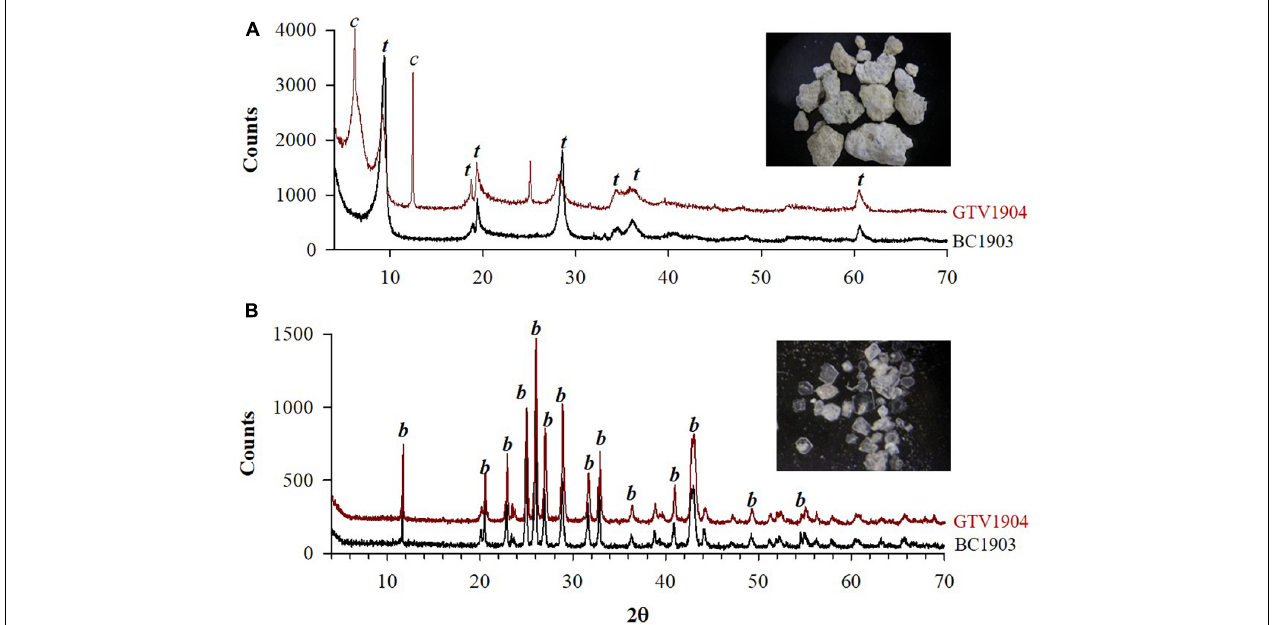
FIGURE 5 | X-ray diffraction spectra of (A) talc and (B) barite grain samples from the OVF surface sediments. t, talc peaks; c, chlorite peaks; b, barite peaks.